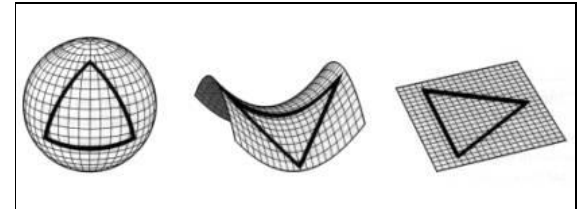
Fig. 21 Geodesics on different surfaces